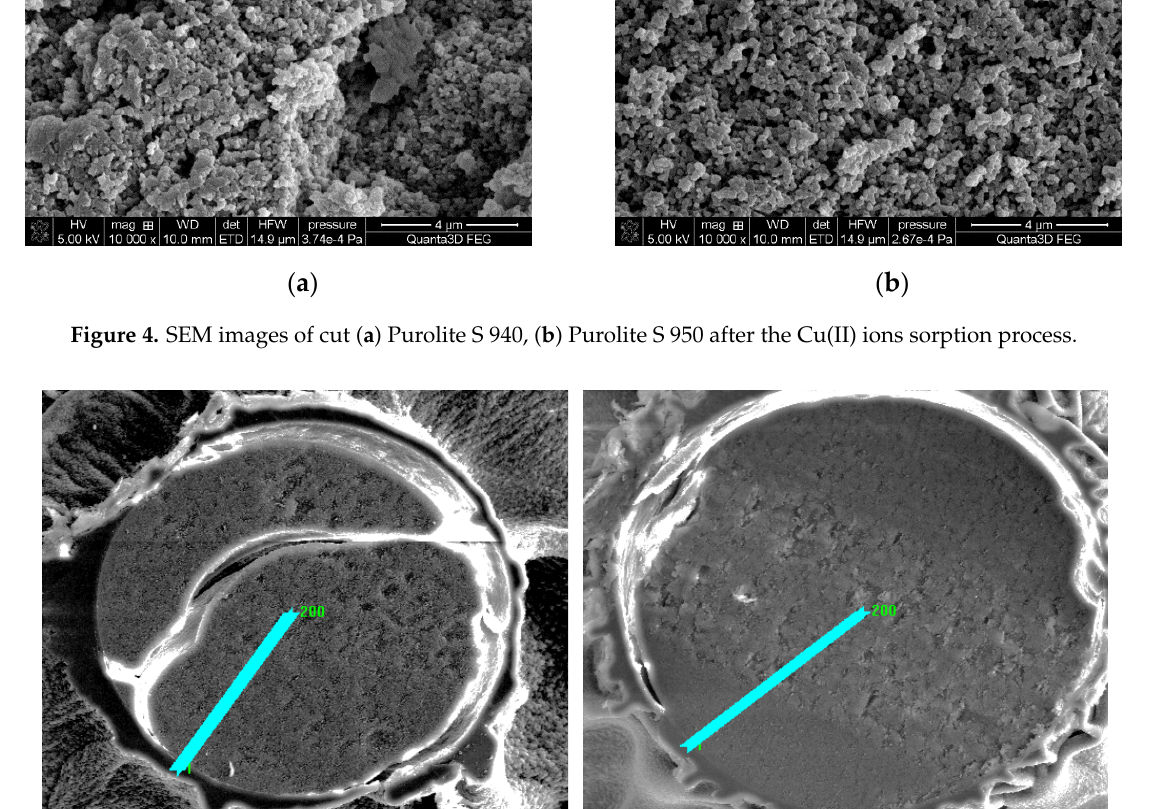
Figure 5. SEM images of lines for the analysis of the elemental composition of cut ion exchangers after the Cu (II) ion sorption process: ( a ) Purolite S 940, ( b ) Purolite S 950.